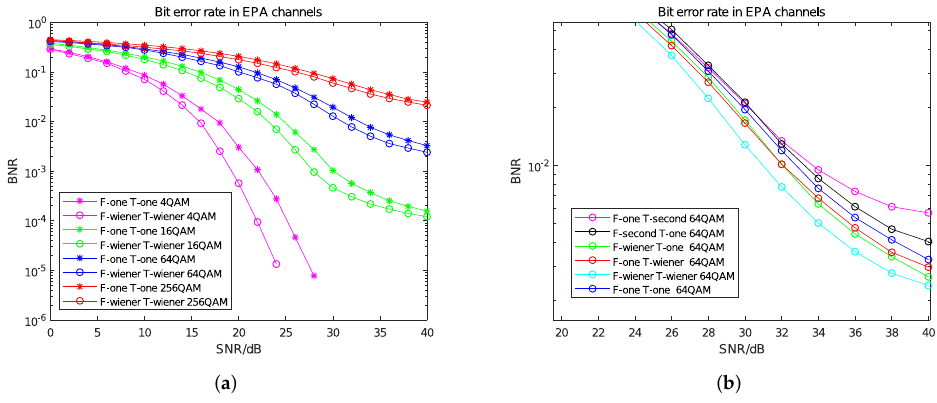
Figure 5. BER curve in EPA channels. ( a ) Comparison of BER curves between Wiener filter interpola- tion and linear interpolation. ( b ) BER Curves of different interpolation methods under 64